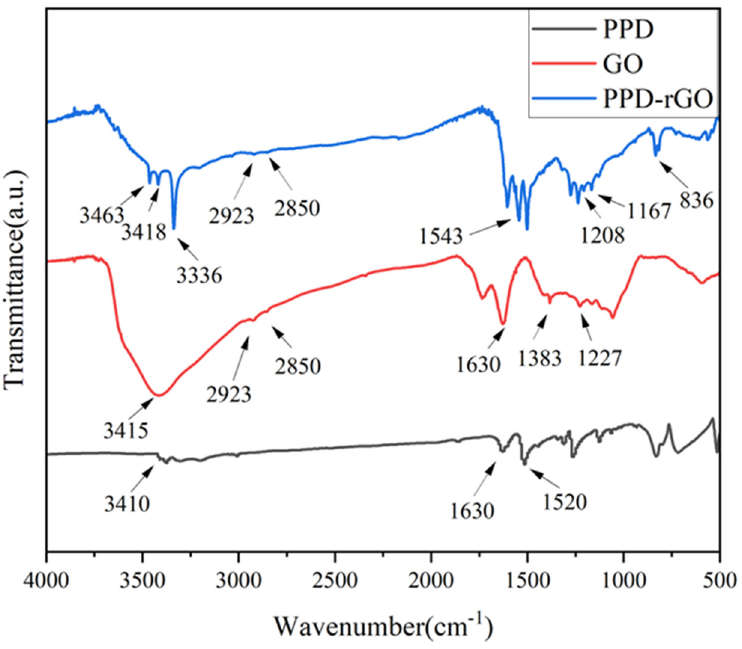
Figure 2. FT-IR spectra of PPD, GO and PPD-rGO.